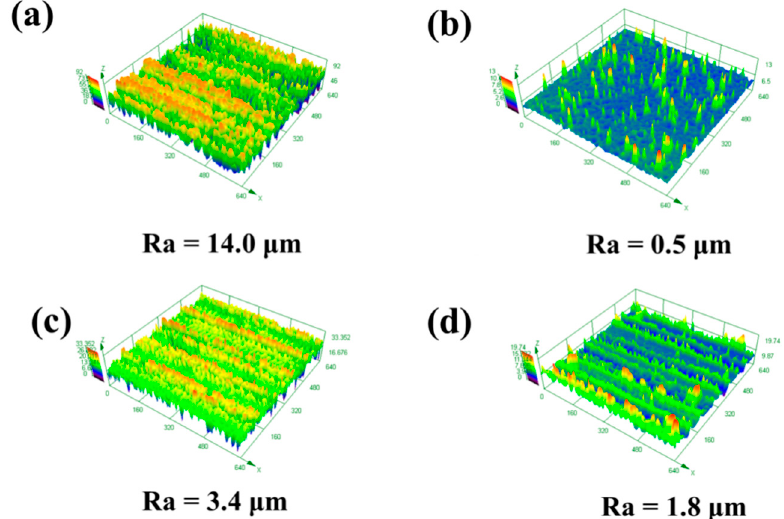
Figure 12. The e ff ect of the Y-moving speed on the three-dimensional morphology of the cleaned surface: Figure 12. The effect of the Y-moving speed on the three-dimensional morphology of the cleaned ( a ) 5 mm / s; ( b ) 7 mm / s; ( c ) 9 mm / s; ( d ) 11 mm / s at the laser X-scanning speed of 1500 mm / s. surface: ( a ) 5 mm/s; ( b ) 7mm/s; ( c ) 9 mm/s; ( d ) 11 mm/s at the laser X-scanning speed of 1500 mm/s.